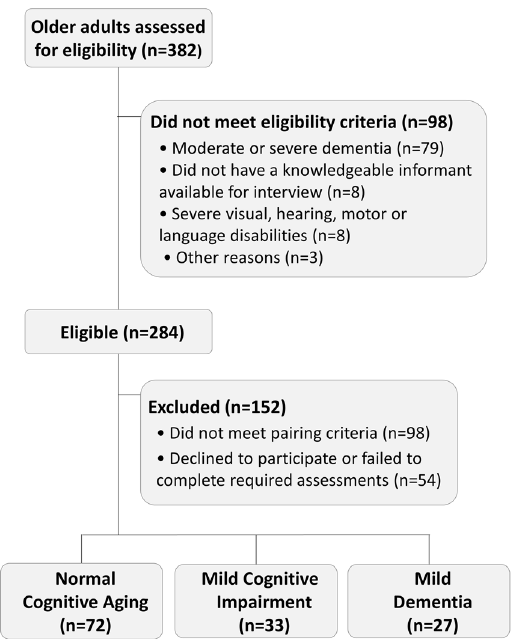
Figure 1. Flowchart depicting the steps involved in the recruitment process.